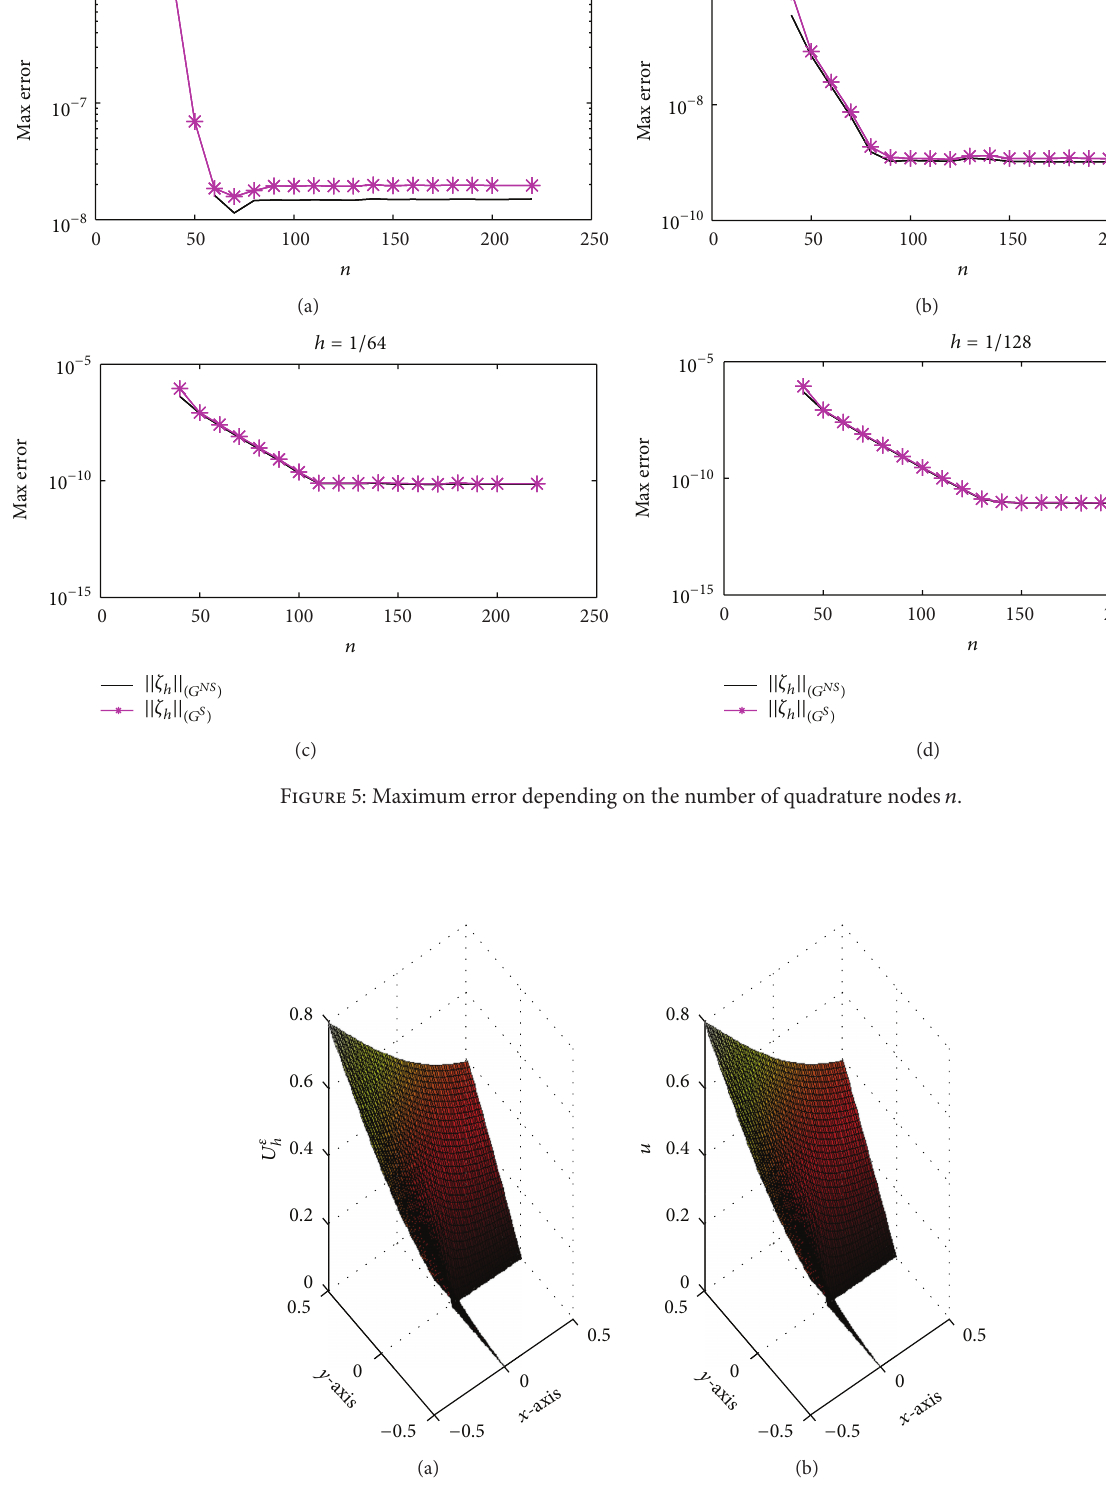
Figure 6: The approximate solution 𝑈 𝜀 ℎ and the exact solution 𝑢 in the “singular” part for 𝜀 = 5 × 10 −13